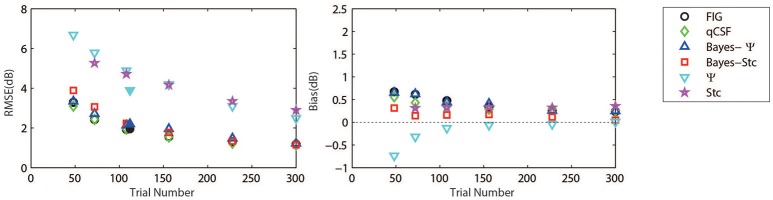
Average precision (left) and relative bias (right) estimates of the methods used in simulation (open symbols) and psychophysical experiments (solid symbols). Symbols of the experimental results are slightly shifted for greater clarity. Different methods are represented by different colors and symbols (see legend).